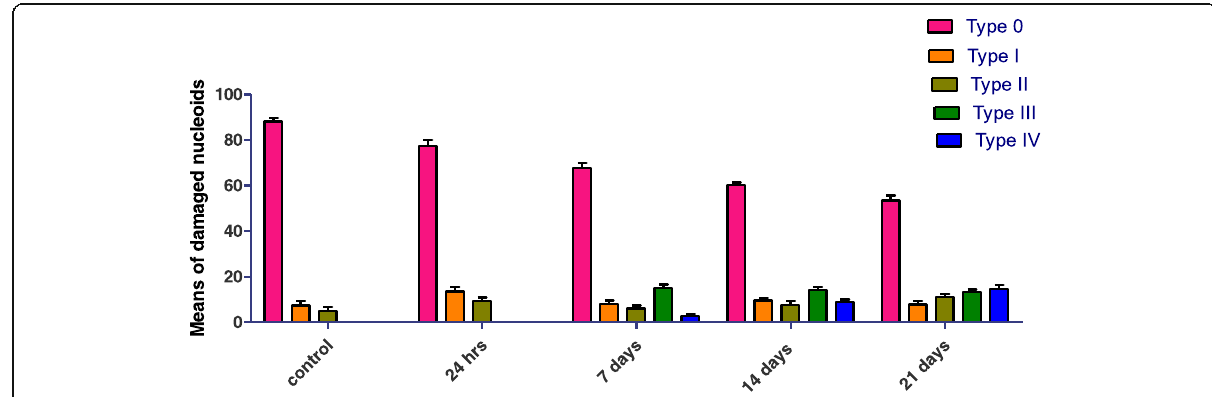
Fig. 8 Graph representing nucleoids in various degrees of damage (mean ± S.D.) in the kidney of C. carpio during sub-lethal exposure to